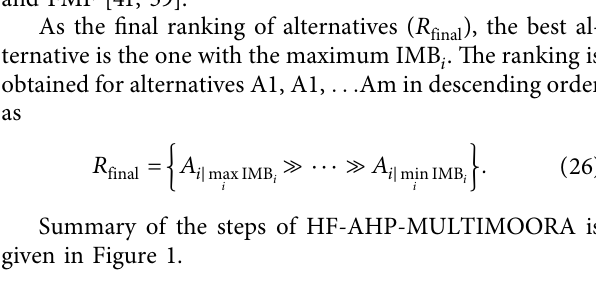
Figure 1: Steps of